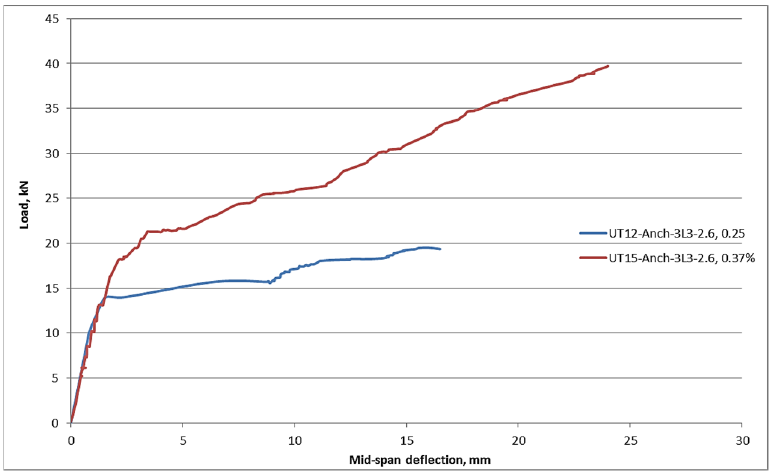
Figure 18. Details of reinforcements in ( a ) UT 12 -Anch-3L 3 -2.6 and ( b ) UT 15 -Anch-3L 3 -2.6 TRC beams.